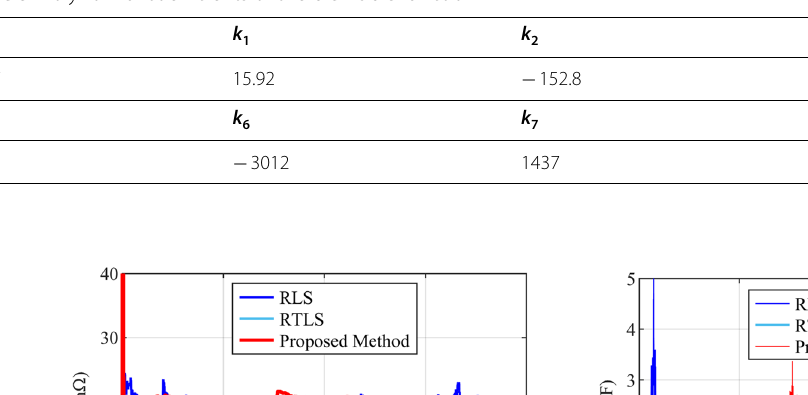
Table 3 Polynomial coefficients of the OCV-SOC function